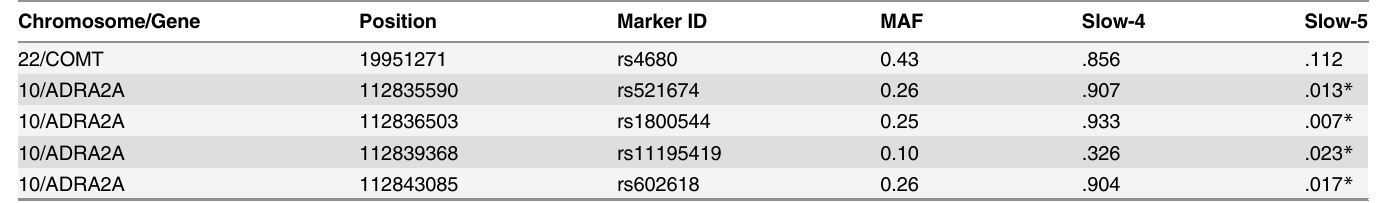
Table 1. The influence of COMT/val158met and ADRA2A gene variants on low-frequency fluctuation measures Slow-4 and Slow-5. Chromosome/Gene Position Marker